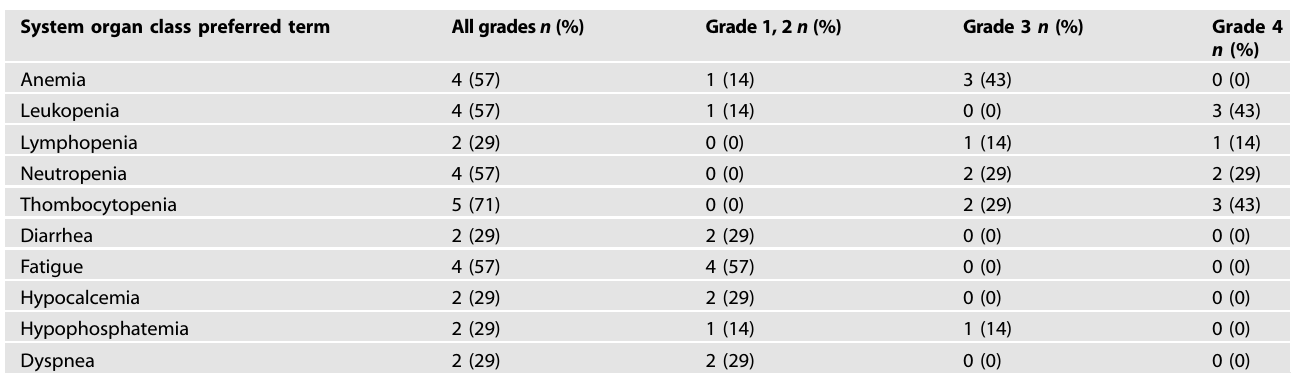
Table 2. Clinical response and treatment-emergent adverse